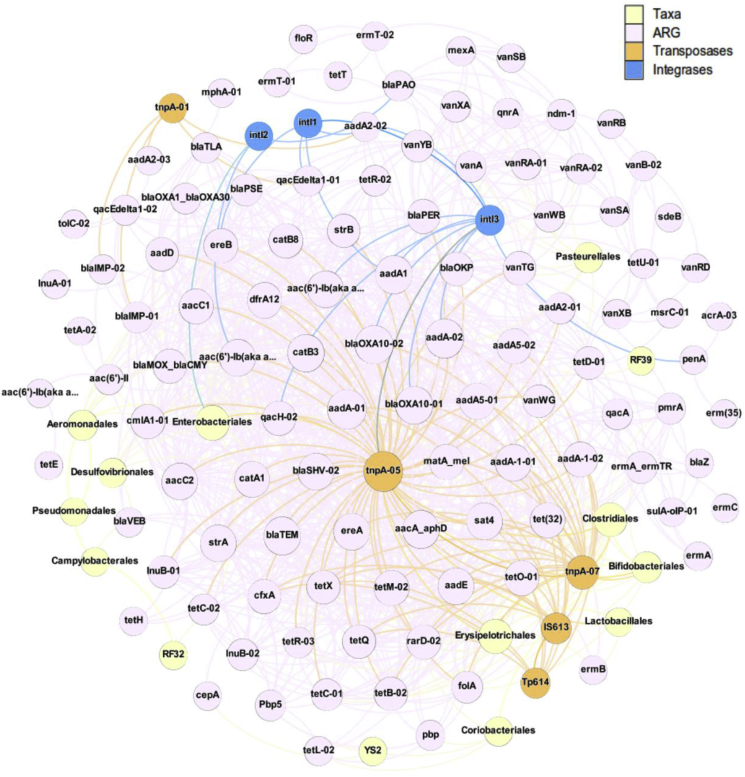
Network analysis revealing co-occurrence patterns among ARG subtypes, taxa (order level), transposons and integrons. A connection represents a strong (Spearman's correlation coefficient p > 0.8) and significant (P-value > 0.01) correlation. The size of each node is proportional to the number of connections, that is, the degree.